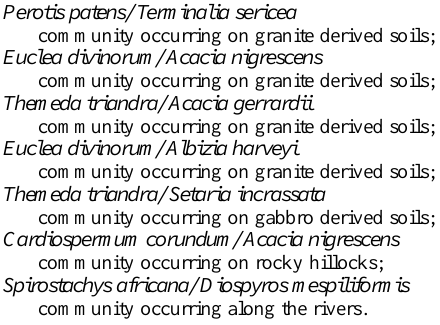
Fig. 2. Medium-term rainfall (13 years) recorded at three weather stations in close proximity to the Manyeleti Game